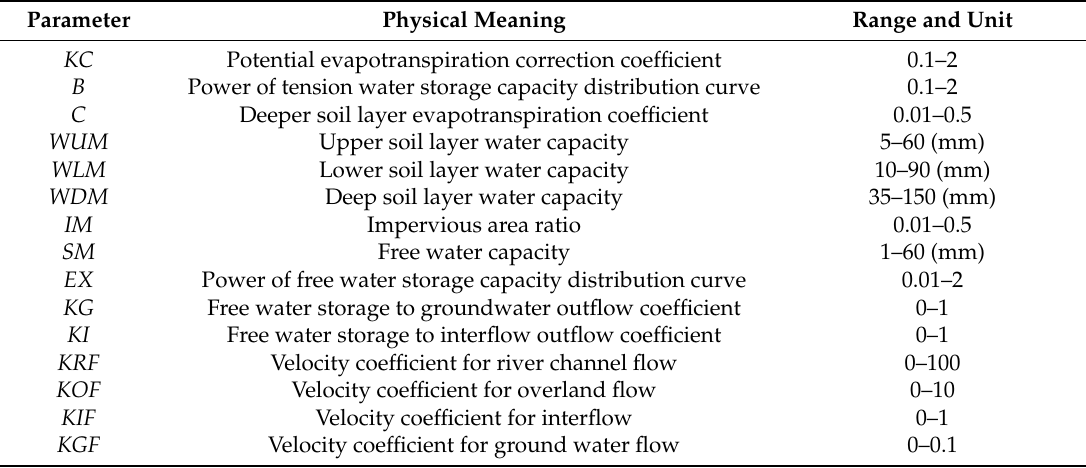
Table 1. Parameters and their boundaries of the CREST 3.0 model